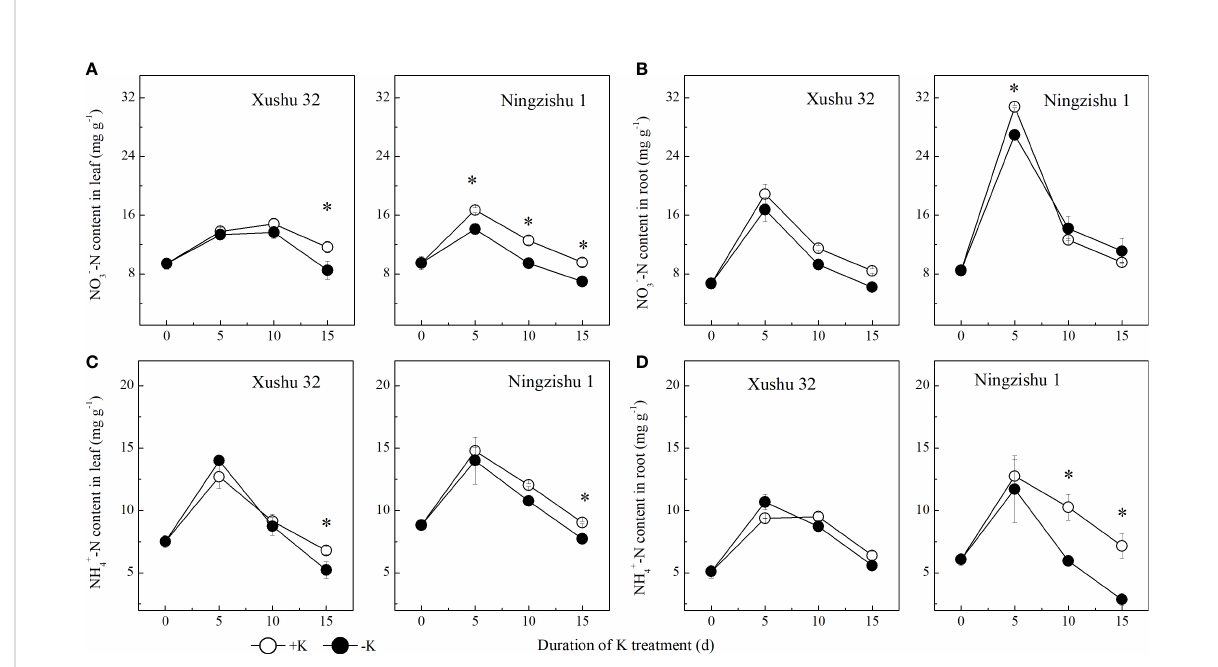
FIGURE 5 Changes of NO 3 − – N and NH 4+ – N content in leaves and roots for two K treatments for Xushu 32 and Ningzishu 1. (A, B) leaf and root NO 3 − – N contents. (C, D) Leaf and root NH 4+ – N contents. The stages labeled with an asterisk (*) indicate signi fi cant differences ( p < 0.05) between − K and